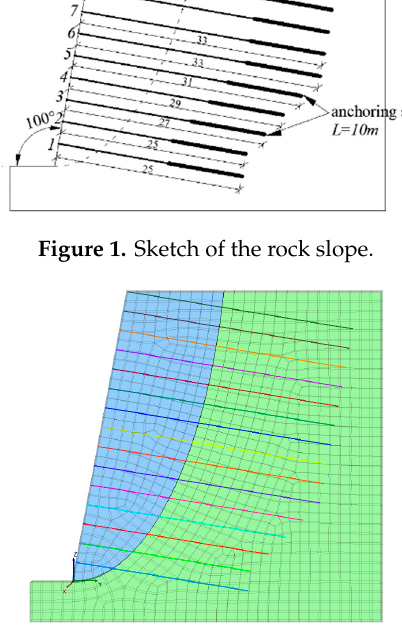
Figure 2. Numerical model of the rock slope.